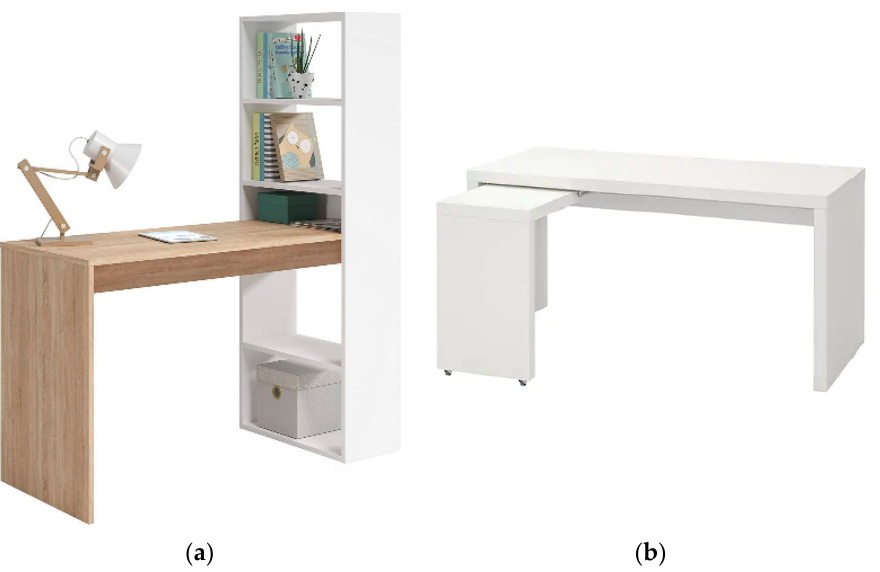
Figure 5. ( a ) Example of a product out of the range and ( b ) the current product which can be related to ( a ).